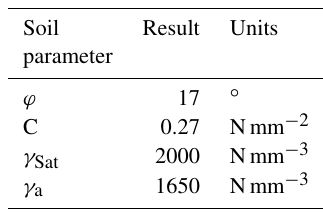
Table 3. Summary chart of the soil analysed at the Geolen S.A. lab- oratory. Bold values show, according to the data of the field pen- etrometers, the depth mobilized by the rotational